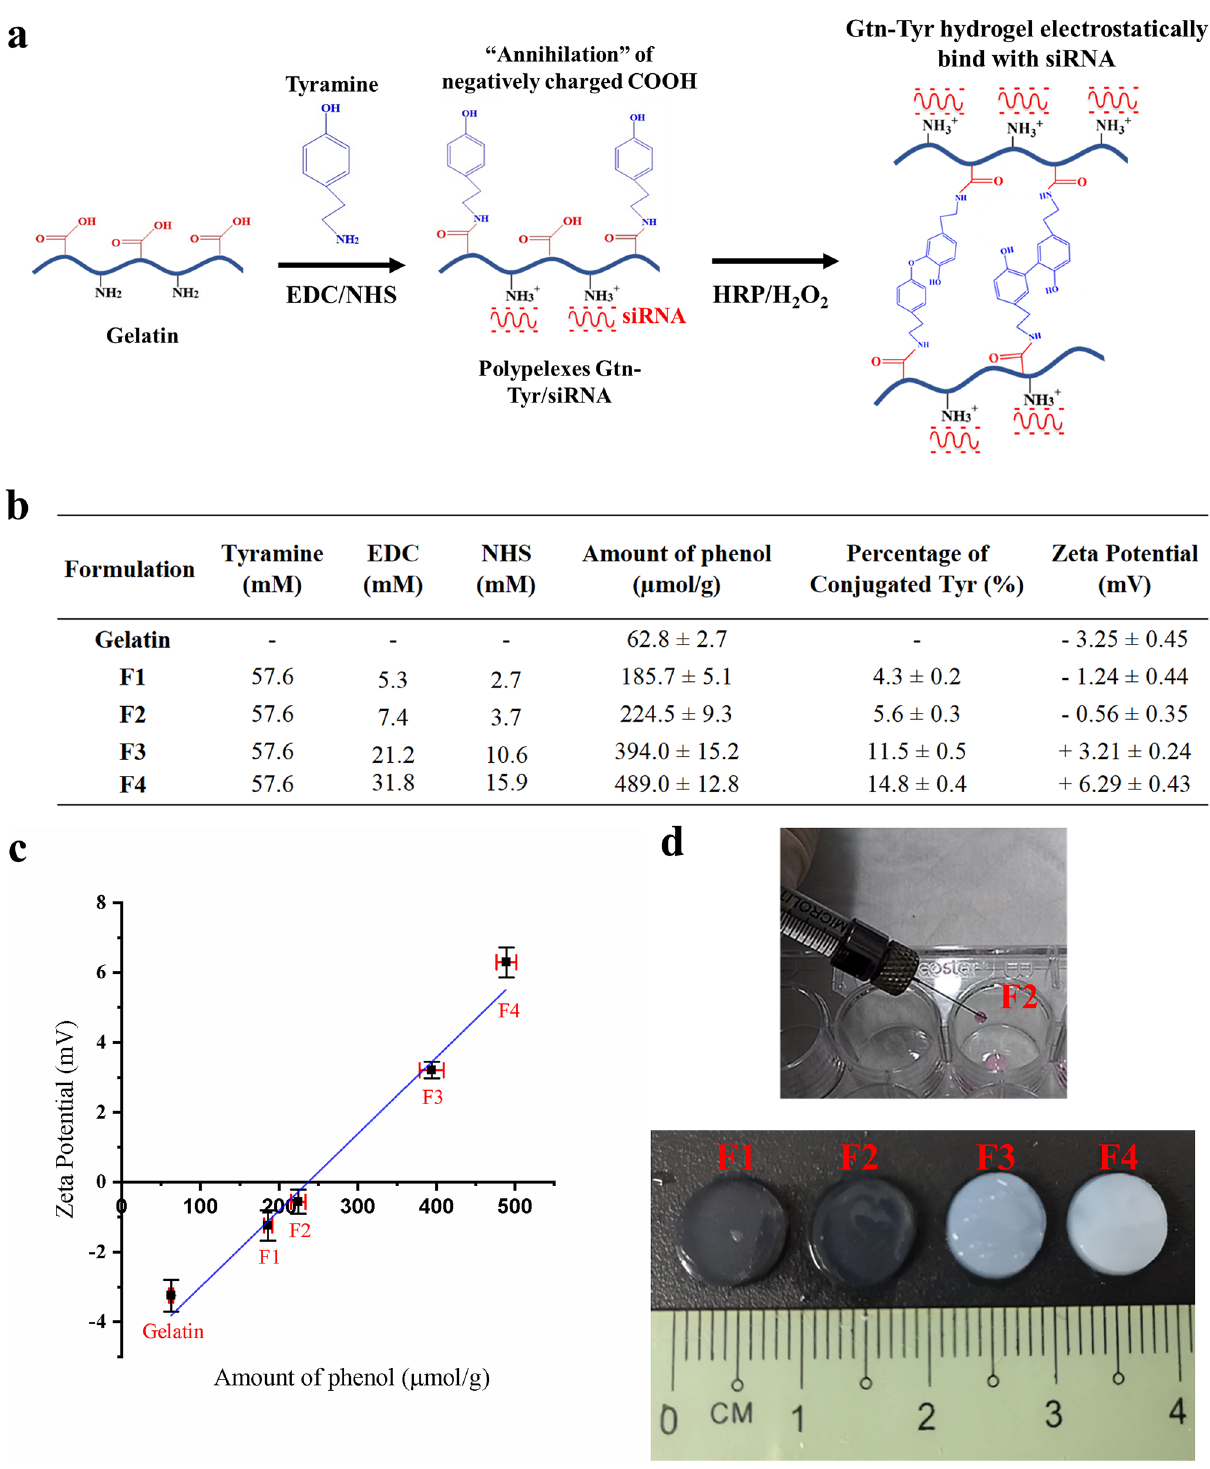
Figure 1. ( a ) A scheme showing a two-step hydrogel synthesis process involving the introduction of tyramine for positive-charge tuning and crosslinking bifunctionality, follow by peroxidase-mediated phenol coupling for hydrogel-siRNA formation. ( b ) A table showing various formulations used for the synthesis of gelatin-tyramine (Gtn-Tyr) precursors, resulting in an increasing percentage of conjugated tyramine and zeta potential. ( c ) A graph showing a linear relationship between the increasing amount of conjugated Tyr with phenol group and zeta potential. ( d ) Gtn-Tyr precursor displaying ease of injectability through a 32G Hamilton syringe, with the hydrogel formed displaying increasing opacity with increasing zeta